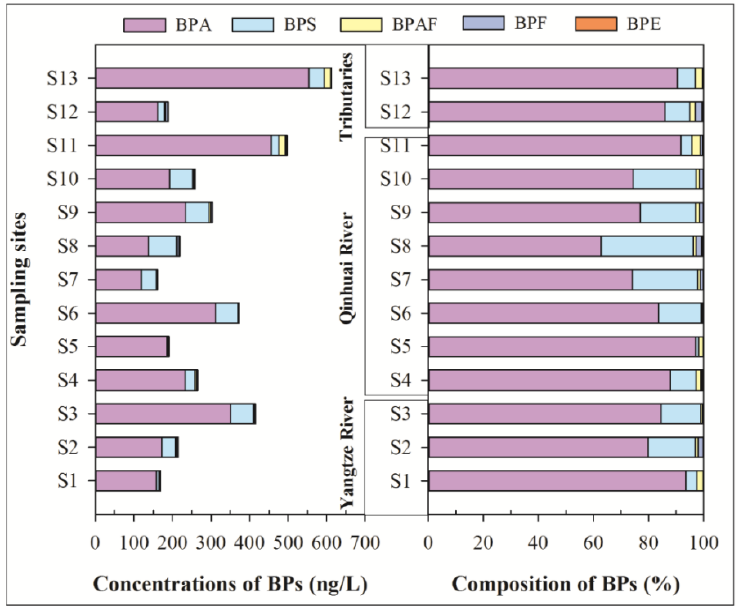
Figure 3. Concentrations and composition of BPs in the colloidal phase of surface water.